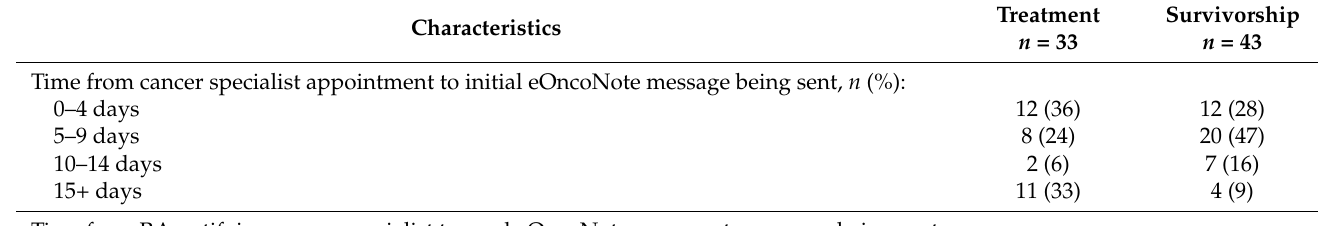
Table 2. eOncoNote discussion